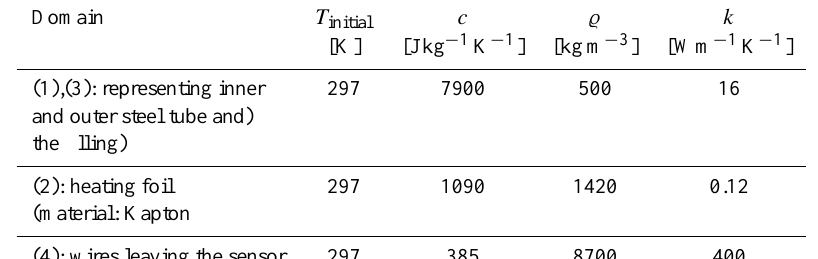
Table 5. Parameters used for the different domains of the LNP01-model.